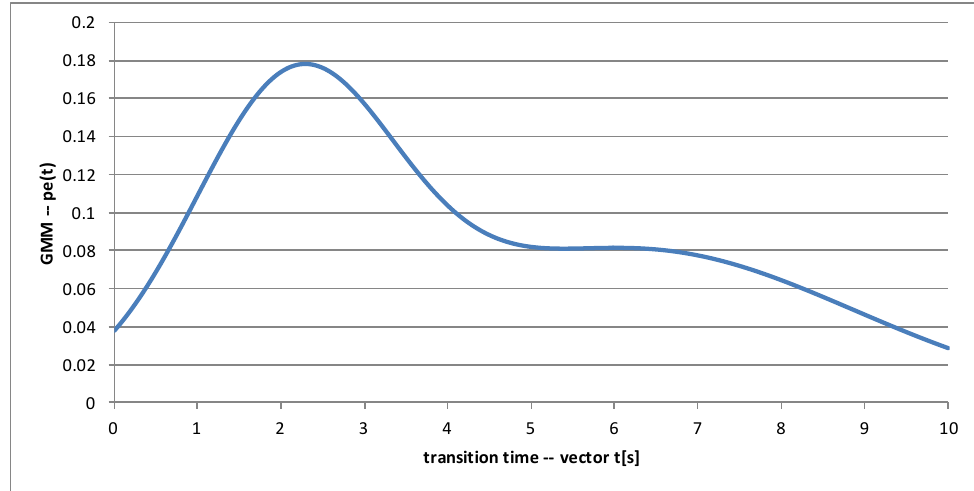
Figure 12. GMM after iteration k = 5 of the EM algorithm.